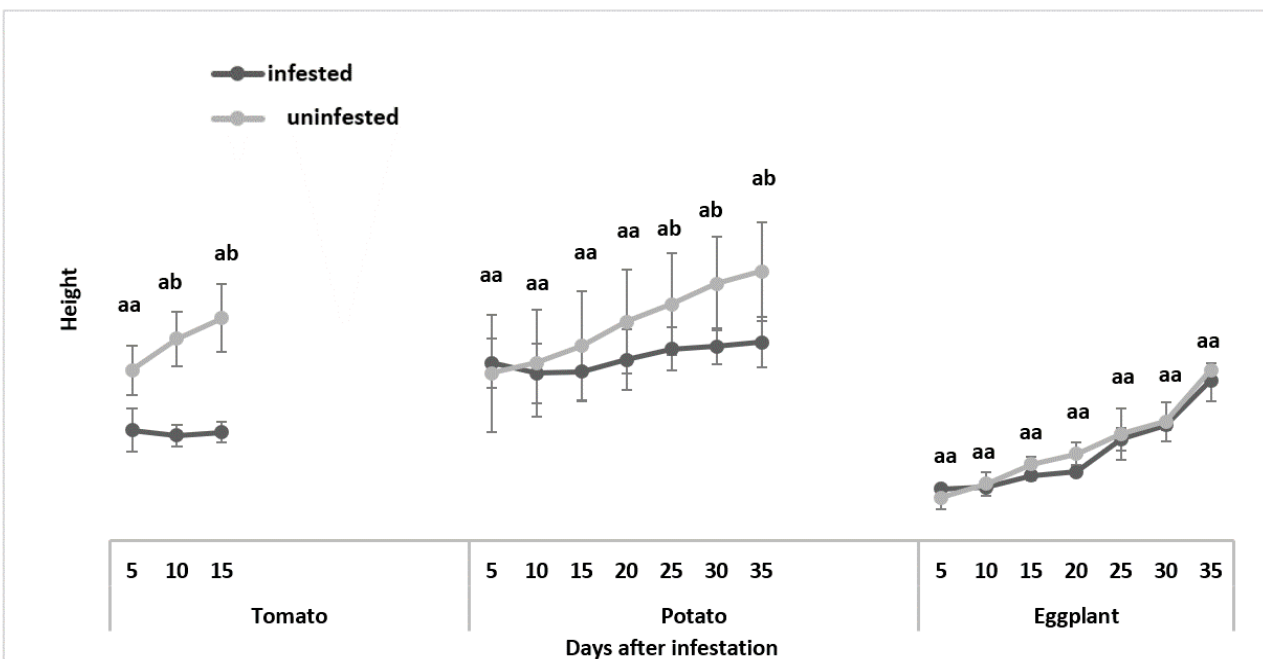
Figure 5. Comparison of mean plant height for uninfested and Tuta absoluta -infested plants. Means followed by different letters in the same bar column are significantly different at p < 0.05.